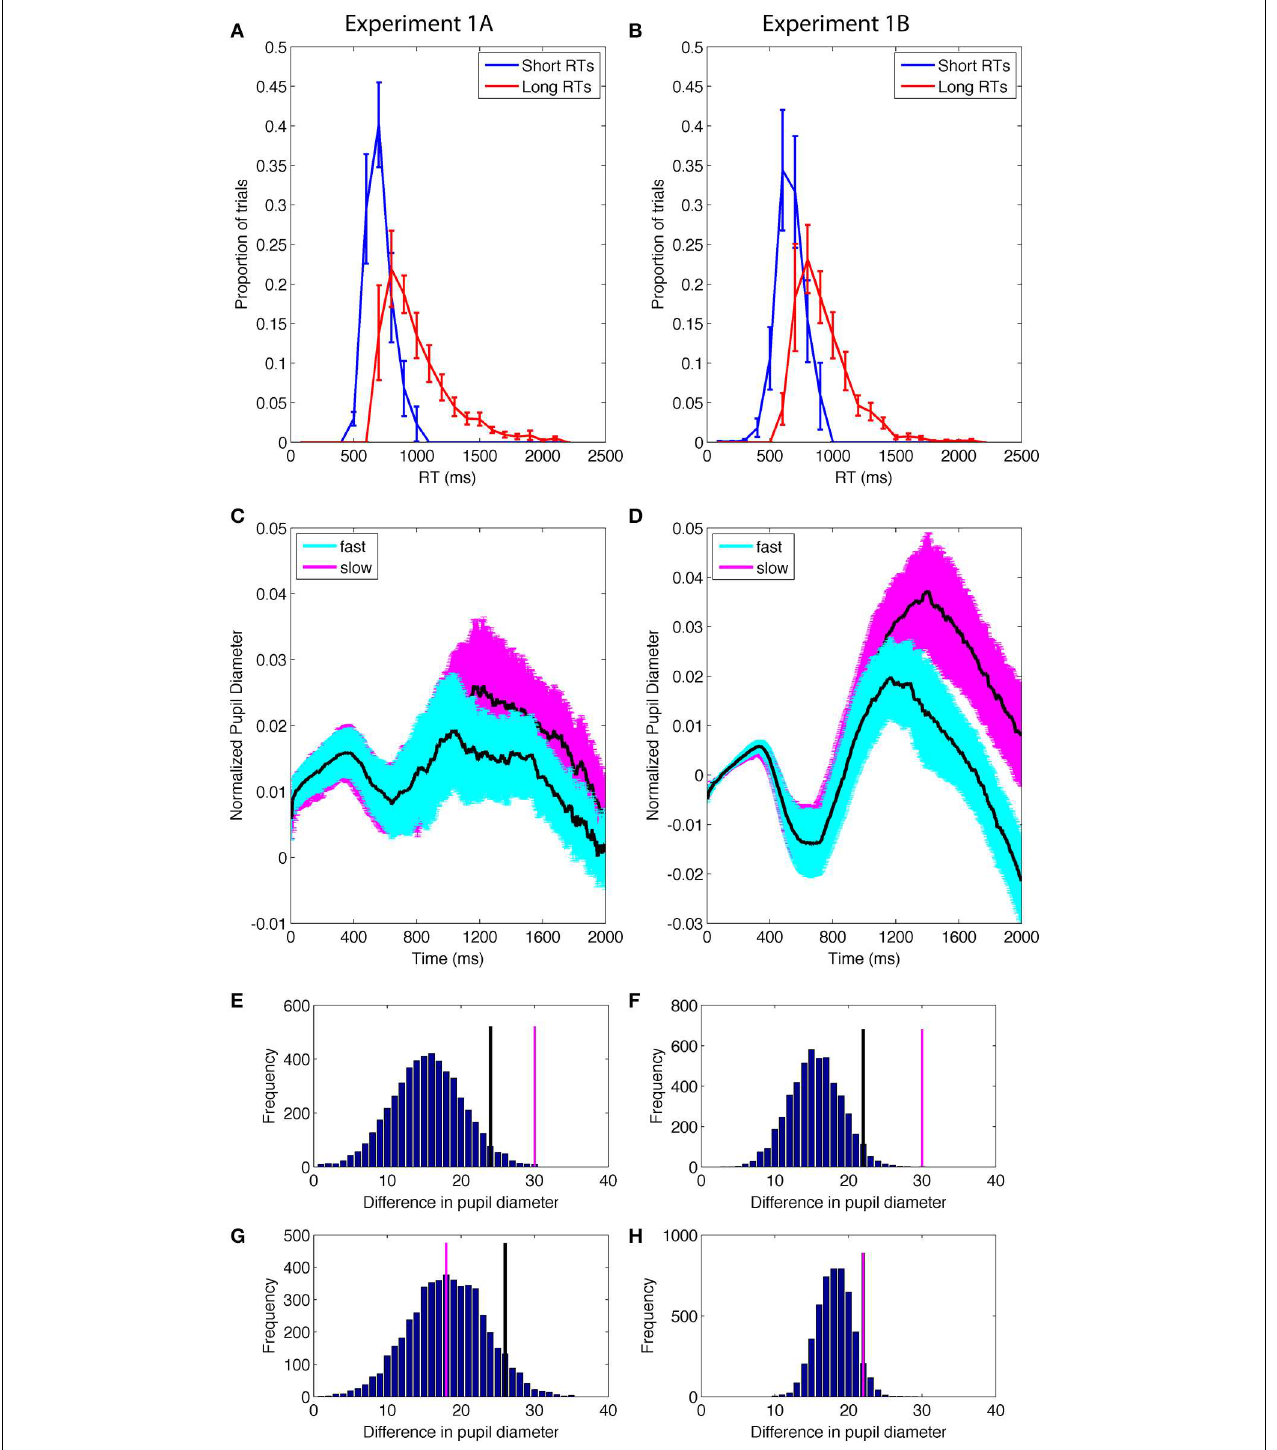
a < 1% probability of occurring due to chance. Black lines identify the top 5% of the permutation results; pink lines are the actual data. (G,H) Permutation results on the difference in pupil diameter as a function of RT from the control time period; the results had a > 5% probability of occurring due to chance, suggesting that difference was not